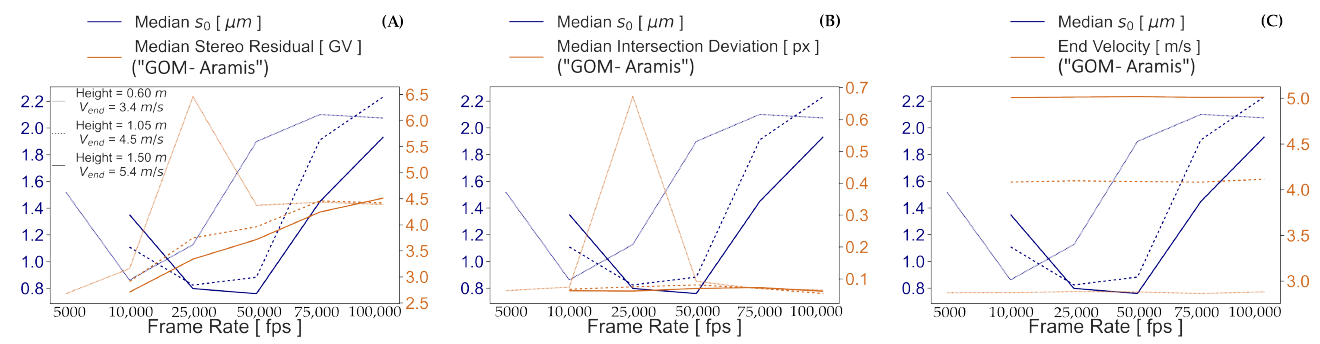
Figure 17. Median s 0 using the RP 06 vs. ( A ) median intersection deviation , ( B ) median stereo residual , and ( C ) end